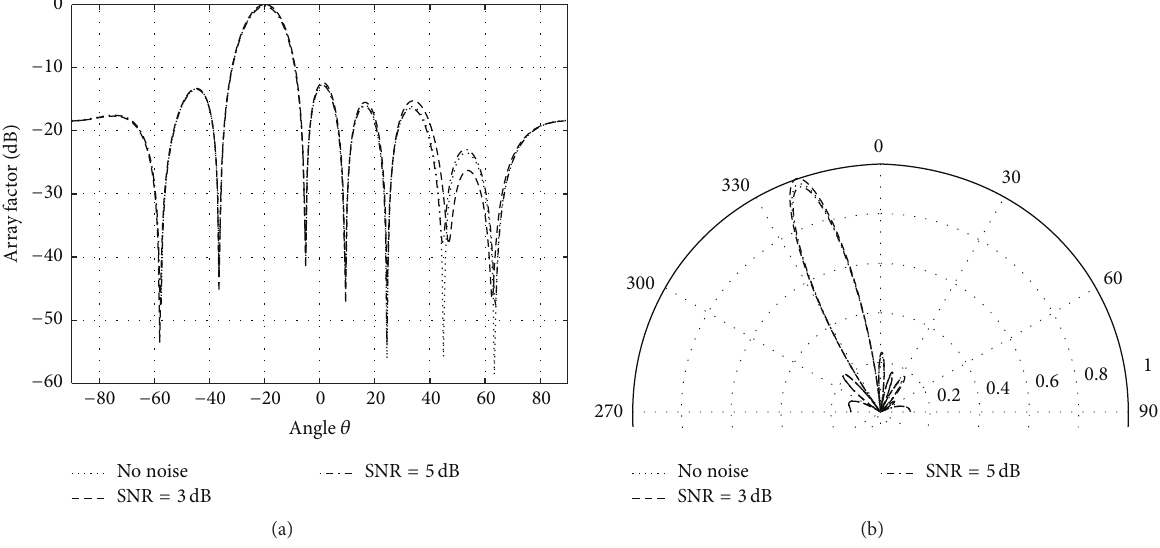
Figure 3: Radiation pattern of normalized array factor for different values of SNR: the angle of arrival of the desired signal is −20 ∘ and the angle of arrival of the interfering signal is 45 ∘ , (a) in the ( 𝑥 - 𝑧 ) plane and (b) in polar coordinates.